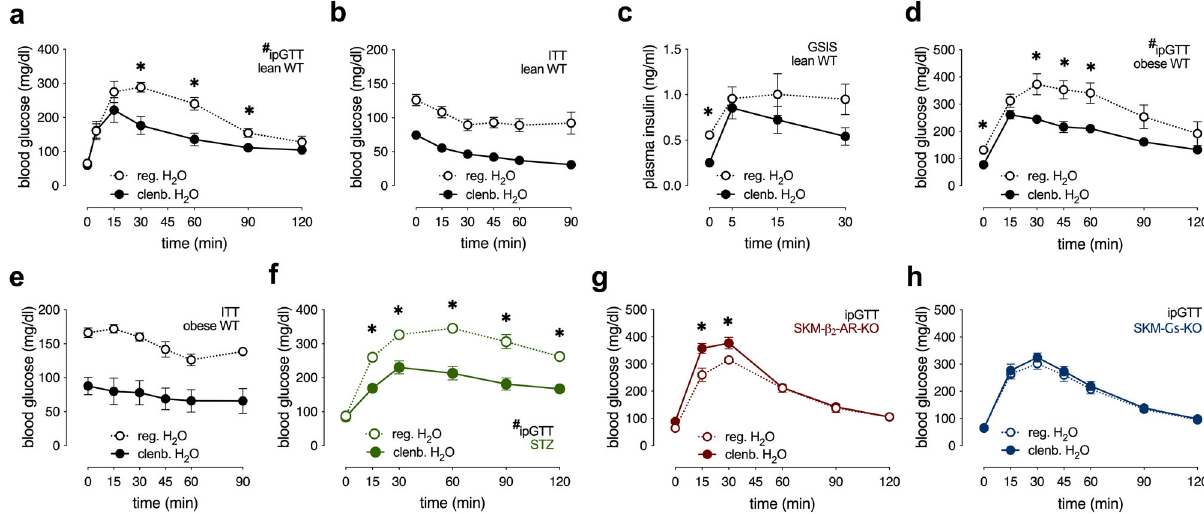
Fig. 1 Chronic clenbuterol administration improves glucose tolerance in mice in a SKM- β 2 -AR-dependent manner. Mice consumed drinking